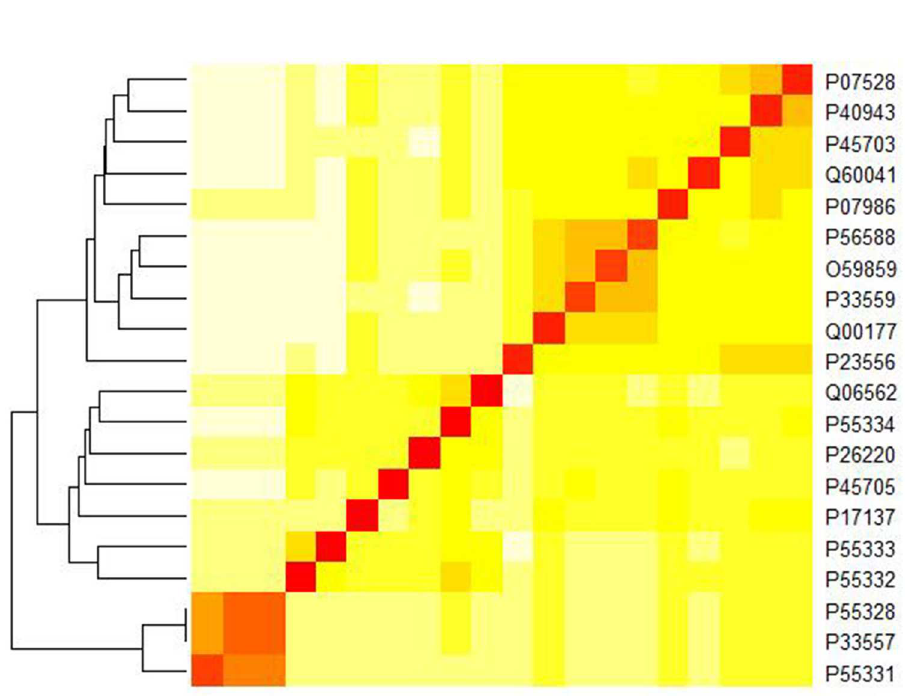
* The table in the literatures listed the correlation coefficient between the corresponding method and ClustalW.